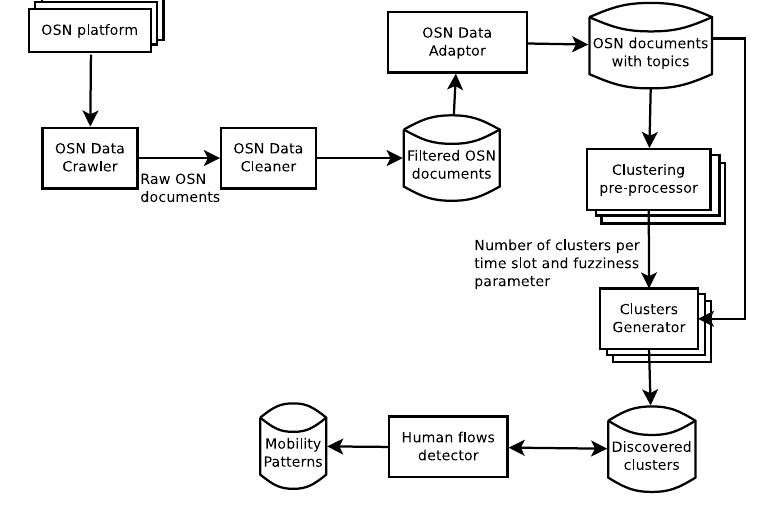
Figure 2. Architecture of the solution. Table 1. Framework